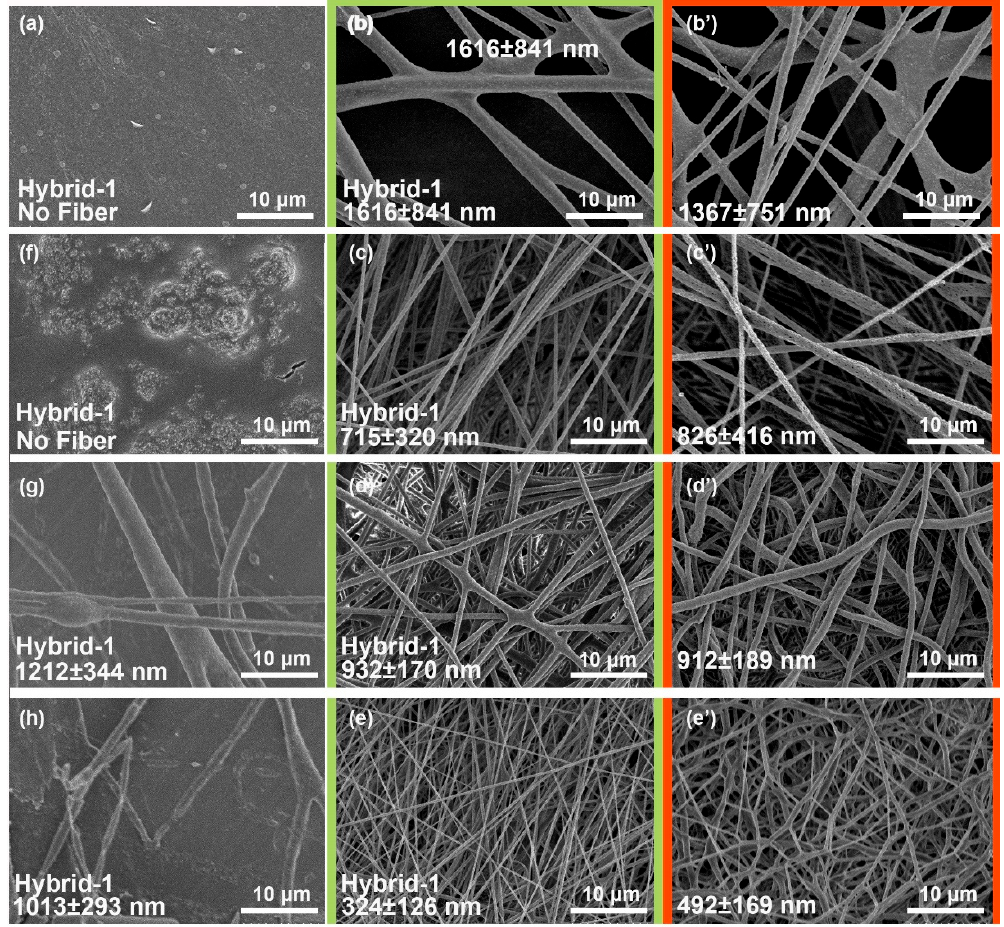
Figure 3. SEM of PTFE–PAI–PEO nanofiber with different parameters of spinning solution. ( a ) hybrid–1, ( b ) hybrid–2, ( c ) hybrid–3, ( d ) hybrid–4, ( e ) hybrid–5, ( b’ – e’ ) PTFE–PAI nanofiber after sintering